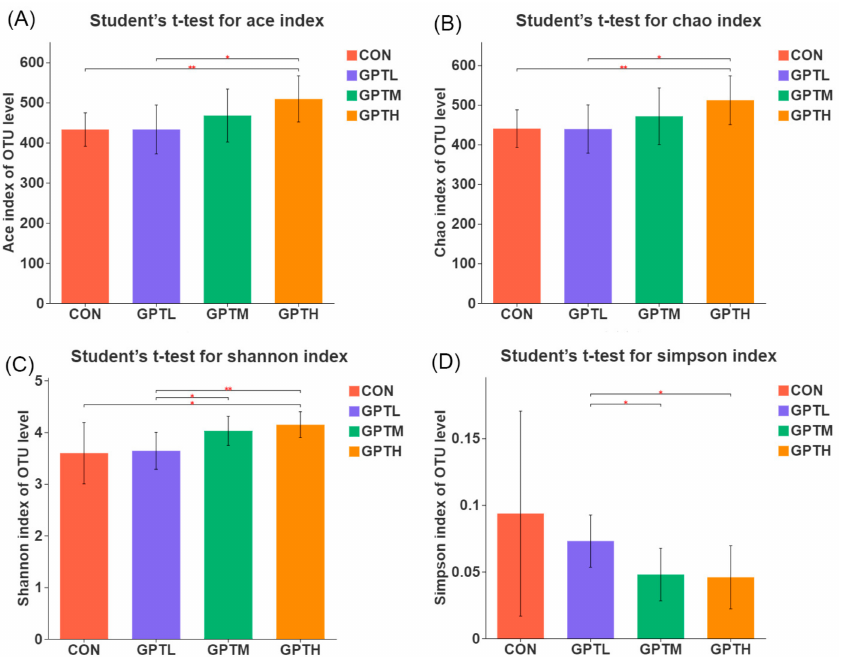
Figure 4. Effects of fed tea treatment on the α -diversity of the fecal microbiota in mice ( n = 10). ( A ) ACE index, ( B ) Chao index, ( C ) Shannon index and ( D ) Simpson index of each group ( n = 10, * p < 0.05, ** p < 0.01).